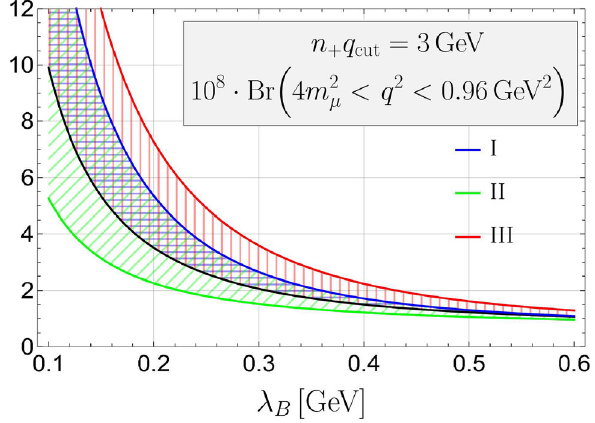
Fig. 10 Branching ratio (in 10 − 8 ) of the B − → μ − μ + e − ¯ ν e decay mode in the [ 4 m 2 μ , 0 . 96 ] GeV 2 q 2 bin for the three B LCDA models of (4.4) as a function of λ B at scale 1 . 5 GeV. The bands are obtained by varying the model parameters within their allowed ranges. The solid black curve refers to the exponential model